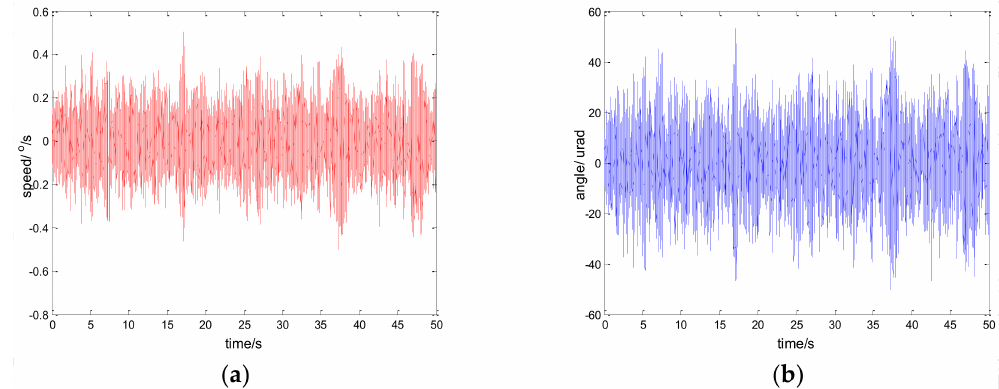
Figure 16. Experiment results of robust SMC with Euler. d = 6sin ( 2 π × 0.1 t ) : ( a ) speed; and ( b ) tracking error, RMS = 13.9755